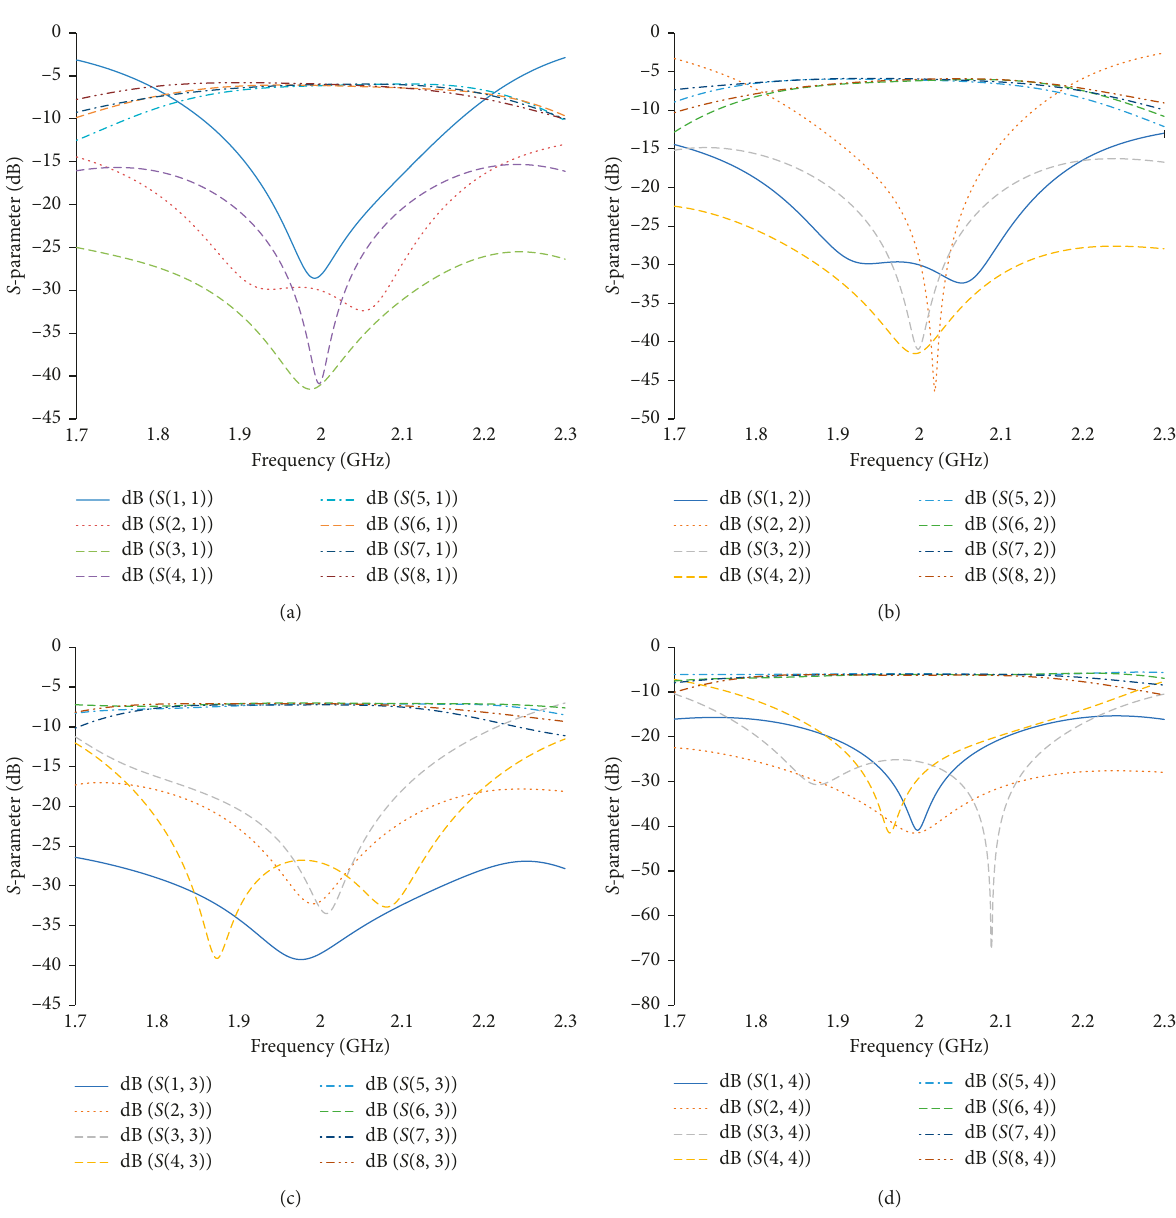
Figure 7: S -Parameter of Butler matrix when: (a) port 1 is excited; (b) port 2 is excited; (c) port 3 is excited; (d) port 4 is